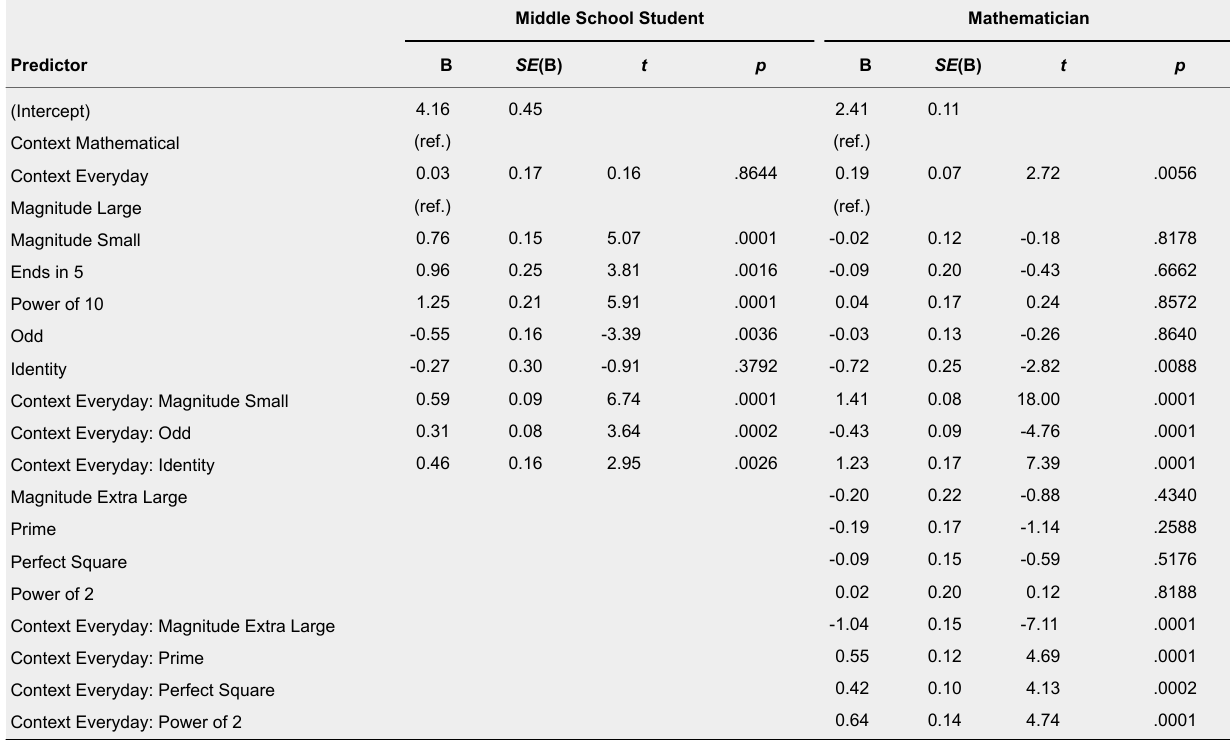
Middle School Students’ (Left) and Mathematicians’ (Right) Regression Model Outputs for the Effects of Mathematical and Everyday Properties of Numbers on Typicality Ratings